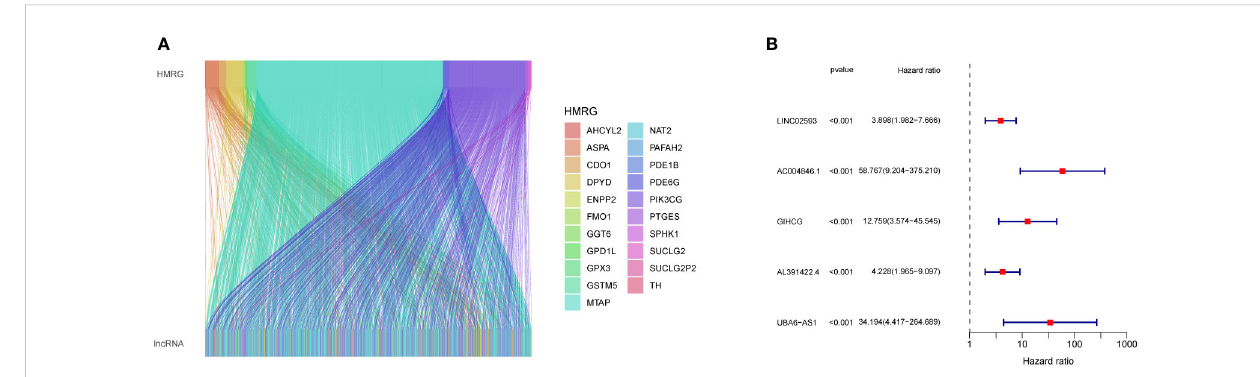
FIGURE 2 Screening of prognosis-related lncRNA. (A) Co-expression network diagram of HMRG and LncRNA. (B) Forest plot showing univariate Cox analysis of lncRNA survival